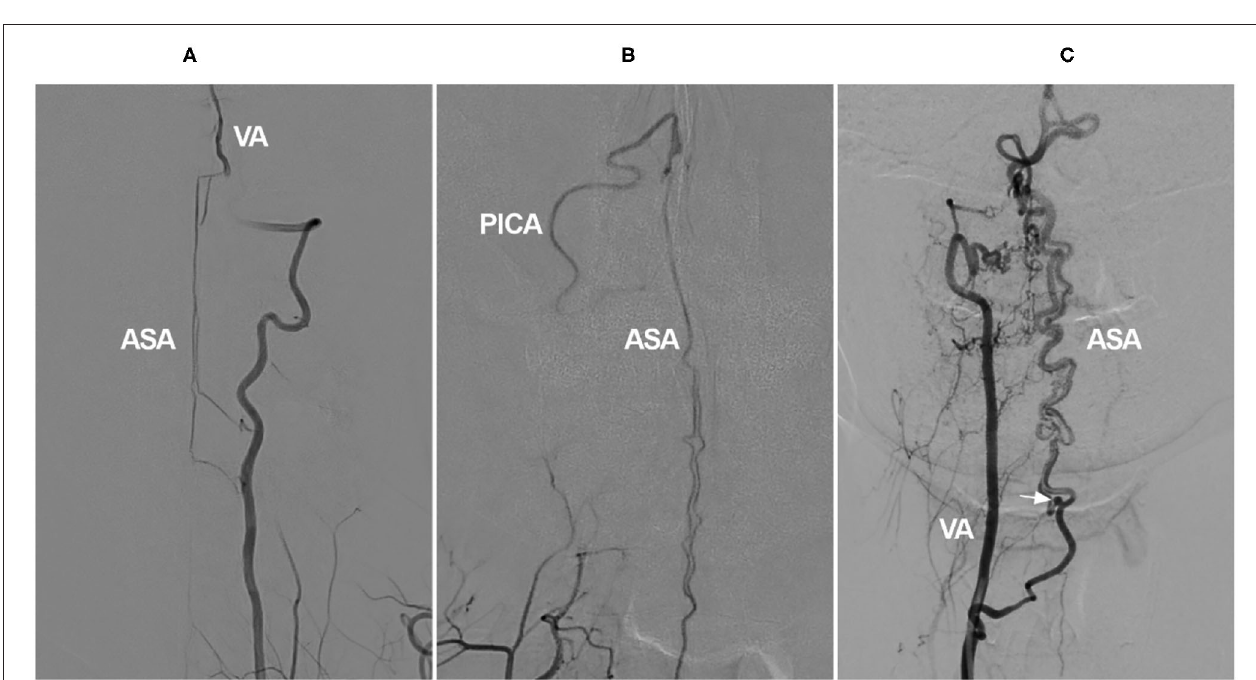
FIGURE 9 | Cervical ASA as a collateral channel in VA occlusion. (A) Angiogram of the VA shows that the intracranial VA is not continuous, and the ASA connects the proximal and distal segments of VA. (B) Angiogram of the VA shows that there are double branches of ASA, and the ASA connects to the PICA. (C) Angiogram of the VA shows the VA rete mirabile; the ASA is tortuous and dilated to provide blood to the posterior circulation, and an aneurysm is found (arrow). ASA, anterior spinal artery; PICA, posterior inferior cerebellar artery; VA, vertebral artery.